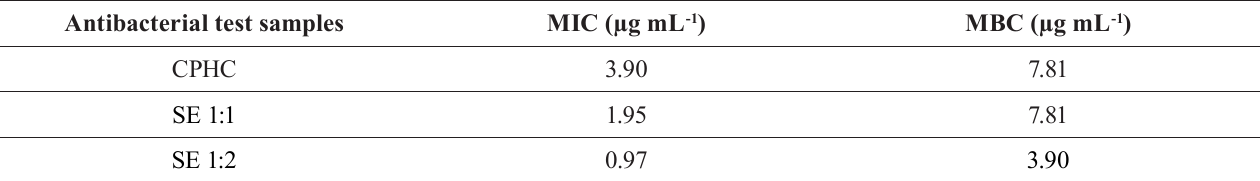
TABLE VII - Minimum inhibitory and bactericidal concentration (MIC, MBC) against Bacillus subtilis for uncomplexed CPHC and inclusion complexes (SE 1:1 and SE 1:2) Antibacterial test samples